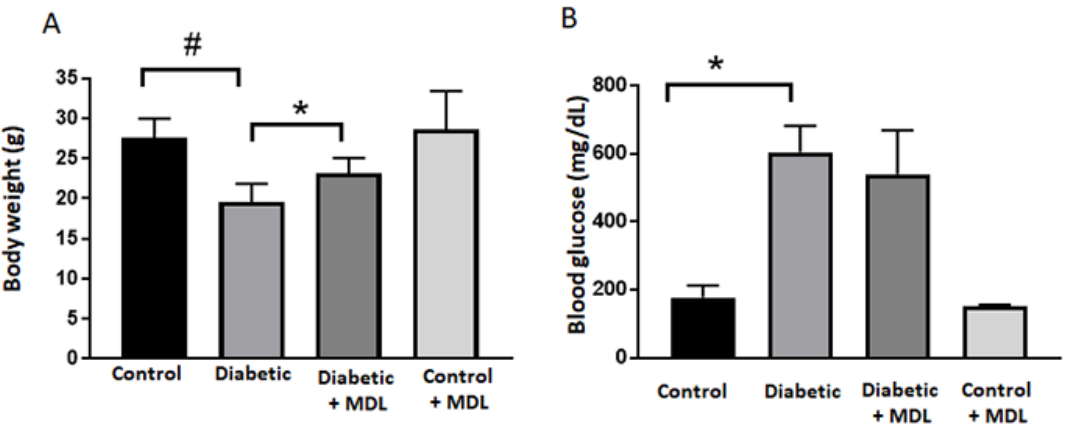
Figure 1. Changes in blood glucose and body weight. Bodyweight ( A ) and blood glucose levels ( B ) are recorded at the time of sacrifice, in groups of control, diabetic, diabetic + MDL, and control + MDL. Data represented as mean ± SD. * p < 0.05; # p < 0.01. N = 6–12 per group.